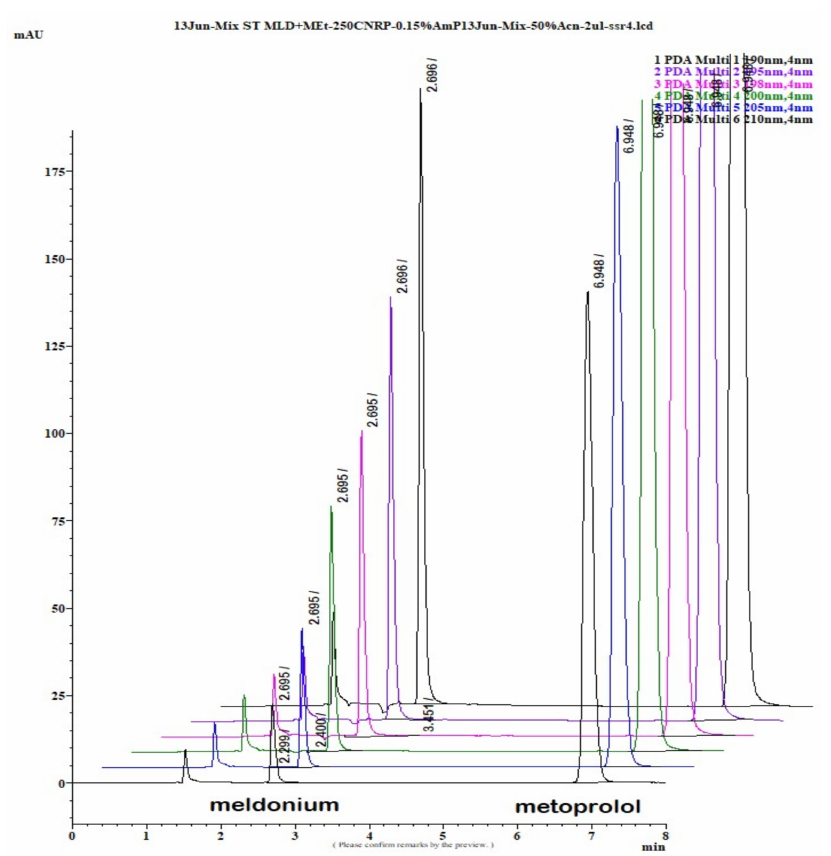
Figure 16. Chromatogram of sample 2.5 mg/mL meldonium and 0.5 mg/mL metoprolol with Water